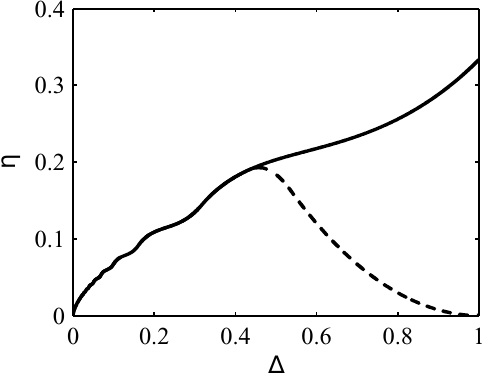
Fig. 8. Non-optimality measure for the constant-force and power-law